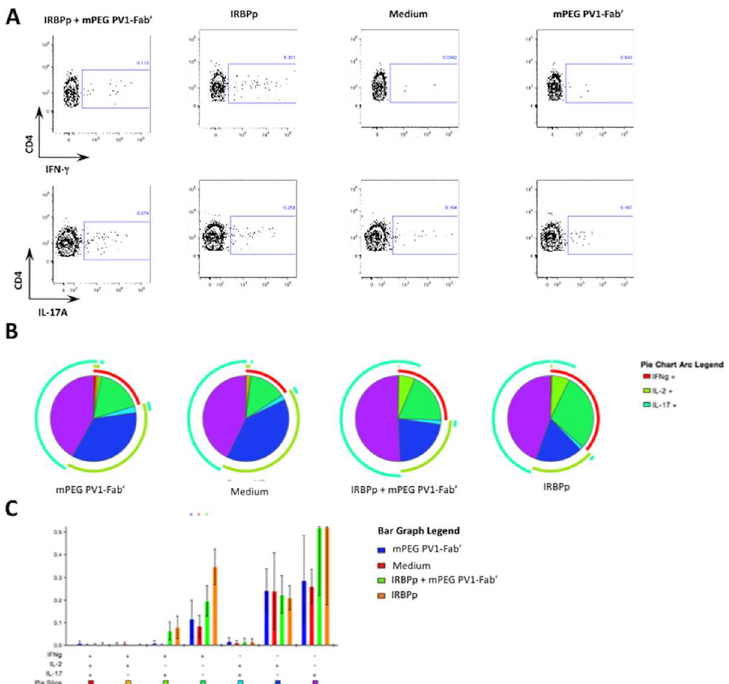
Fig 6. CD28 blockade with mPEG PV1-Fab’ prevents T H 1 cell expansion after antigen re-encounter. B10.RIII mice were immunizedwith 50 μ g/animalof 161–180IRBP in CFA. On day 7 mice were sacrificedand dLN were collectedfor evaluation cytokine production. For the intracellularstainingof IFN- γ , IL-17 and IL-2 cells were collectedfrom dLN, pre-incubated or not with 10 μ g/mLof PV1, and plated at 1x10 6 cells/well concentration and stimulated or not for 48h with IRBP 161–180peptide(IRBPp). (A) Pie charts showingIFN- γ , IL-17 and IL-2 productionby CD3 + CD4 + cells. (B) Absolute frequency of CD4 + IFN- γ + cells. In brief, each subpopulation depictedin the bar graph is also depictedin the pie chart as pie slices, followingthe same color code. Overall IFN- γ , IL-17 and IL-2 production is displayedas the outer arcs in the pie charts. Data combined from three independentexperiments. Mean ± SD are depictedin (B) ** , p < 0.01; *** , p < 0.0001,two-tailed Mann-Whitney